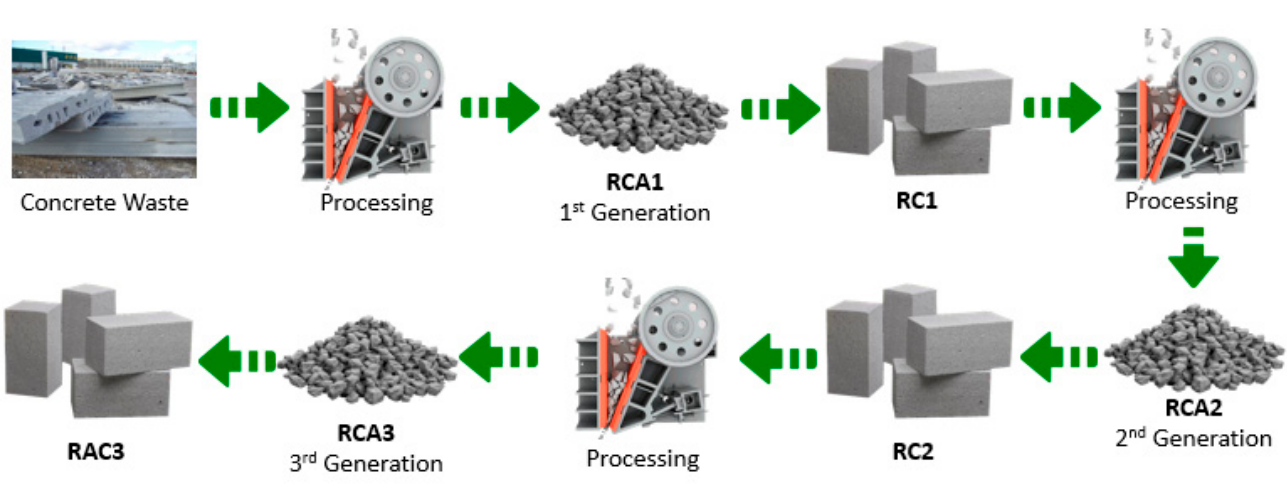
Figure 1. Scheme of repeated use of RCA in repeated RC